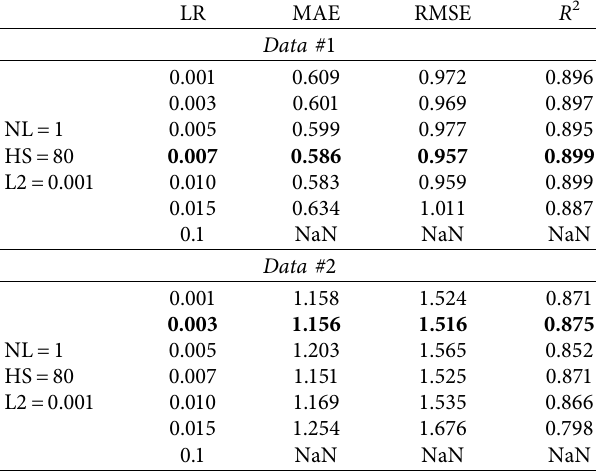
Te bold values means the best results in the data